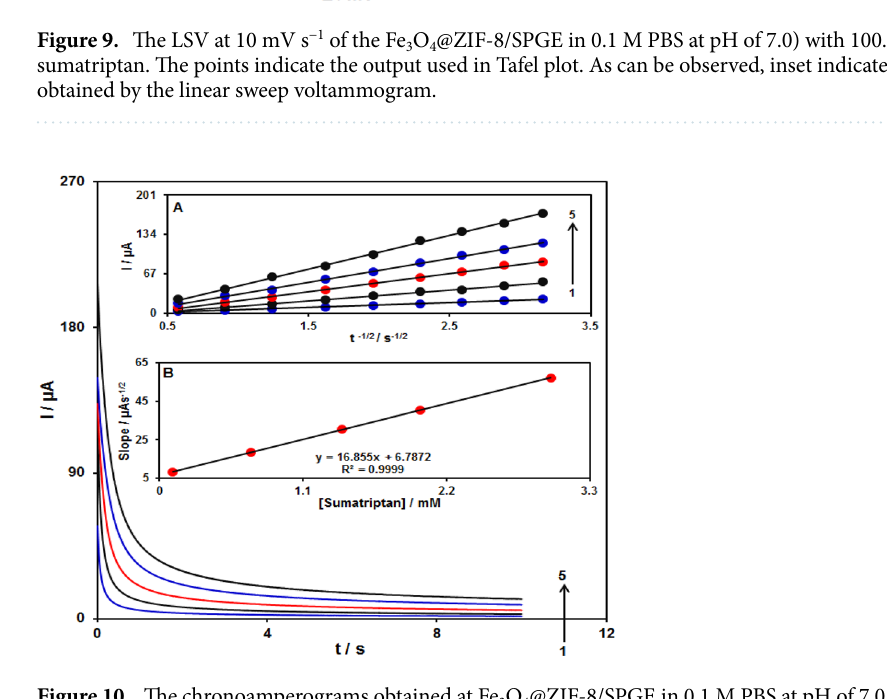
Figure 10. The chronoamperograms obtained at Fe 3 O 4 @ZIF-8/SPGE in 0.1 M PBS at pH of 7.0 for sumatriptan various concentrations. Accordingly, 1–5 relate to 0.1, 0.7, 1.4, 2.0 and 3.0 mM of sumatriptan. Inset A. the I plot versus t −1/2 observed using chronoamperograms 1–5. B. The straight-line slope plot versus sumatriptan